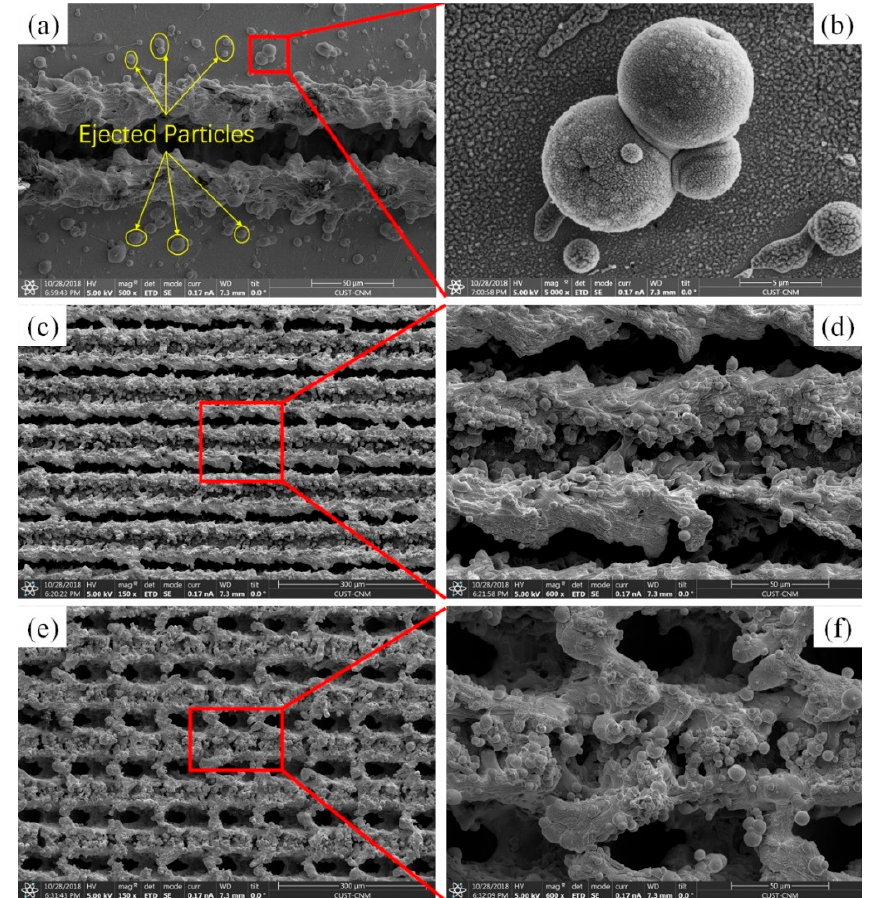
Figure 2. SEM images: ( a ) single groove ablated by nanosecond laser, ( c ) line-patterned surface, ( e ) grid-patterned surface. ( b , d , f ) Corresponding high-magnified SEM images. ( e ) grid-patterned surface. ( b , d , f ) Corresponding high-magnified SEM